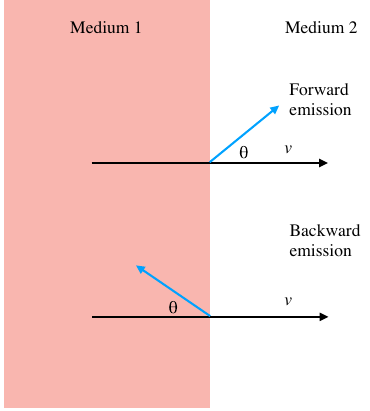
ffiffiffiffiffiffiffiffiffiffiffiffiffiffiffiffiffiffiffiffiffiffiffiffiffi p FIG. 9. Polar angle conventions for forward and backward 2 θ ϵ − ϵ 1 2 sin